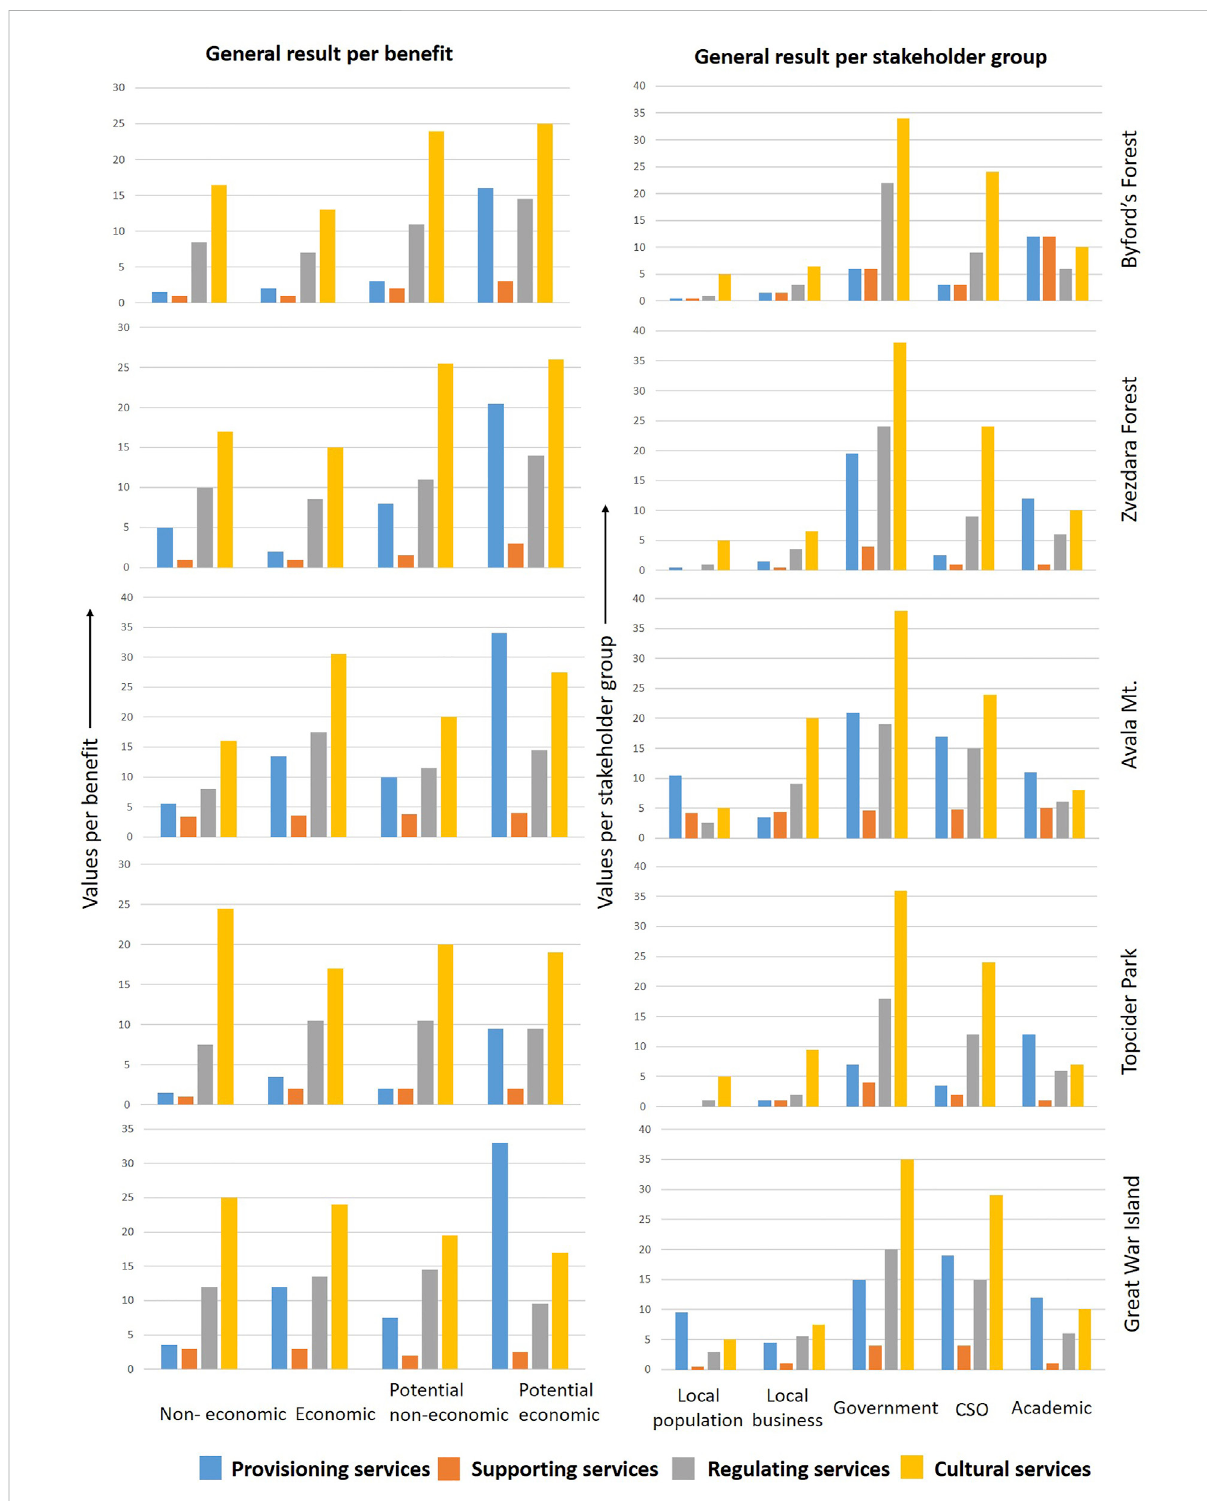
FIGURE 2 Current and potential values of urban protected areas: Byford ’ s and Zvezdara forest, Avala Mountain, Topcider Park, and Great War Island (CSO – Civil society